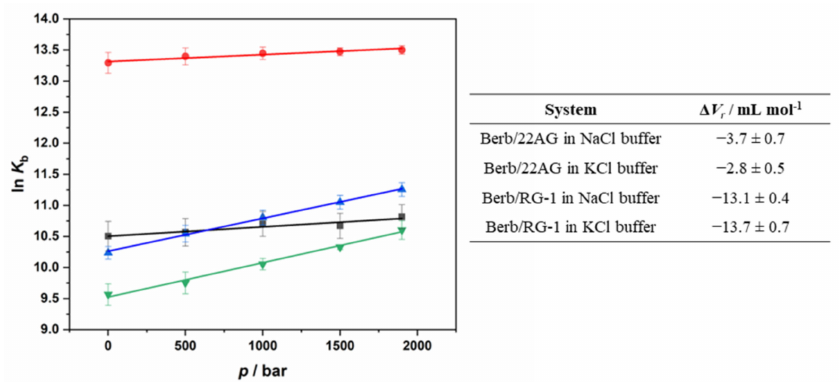
Figure 9. Left: Plots of the natural logarithm of K b vs. pressure (in bar) for the complex formation between berberine and 22AG in the presence of 100 mM NaCl (black squares) and 100 mM KCl (red circles). The pressure dependence of ln( K b ) for the complex formation between berberine and RG-1 is also shown in the same graph: in the presence of 100 mM NaCl (blue triangles) and in the presence of 100 mM KCl (reversed green triangles). The evaluation of the reaction volume, ∆ V r , was determined from the slope of the plots. Right: Reaction volumes, ∆ V r , for the complex formation between berberine and the G4Qs (22AG and RG-1) for the reported solution conditions (30 mM Tris-HCl, pH 7.4, with the addition of 100 mM NaCl or 100 mM KCl) at the temperature of 25 ◦